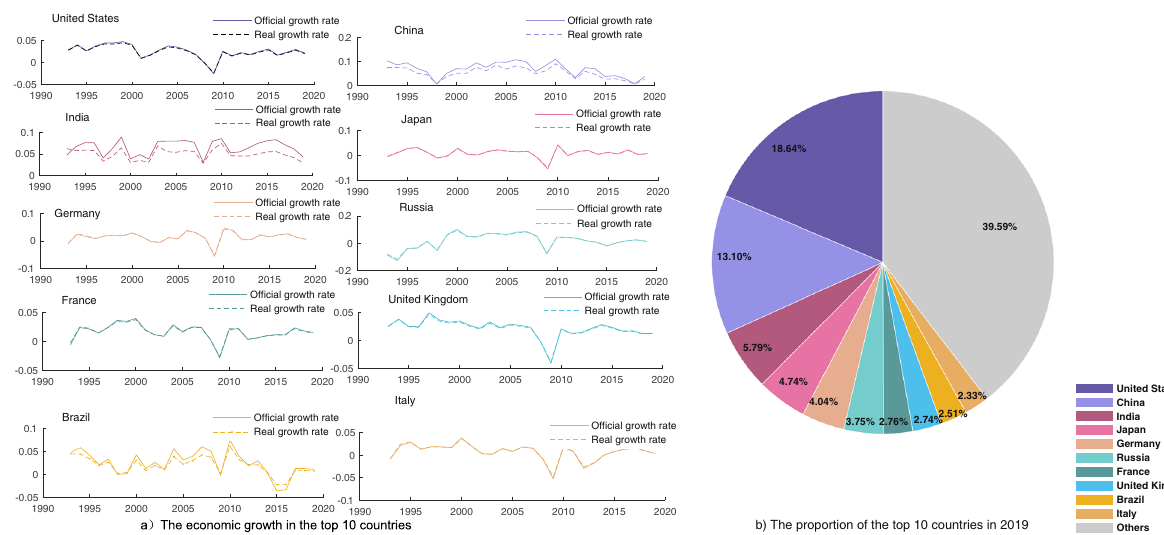
Fig. 2 Top ten countries ’ real GDP growth and real GDP. a Comparison of the top 10 countries ’ of fi cial GDP growth and real growth based on night-time light data obtained from 1992 to 2019. b Proportion of the top 10 countries ’ GDP in the worldwide economic output. Note: ‘ China ’ here refers to China ’ s